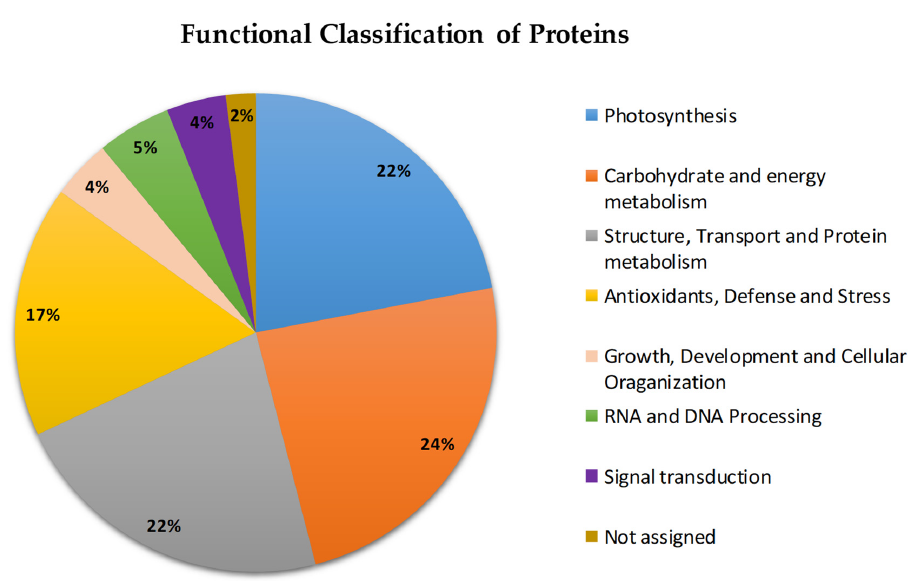
Figure 1. Functional classification of the proteins identified in P. fasciculatum leaves exposed to Cd stress for 60 days.